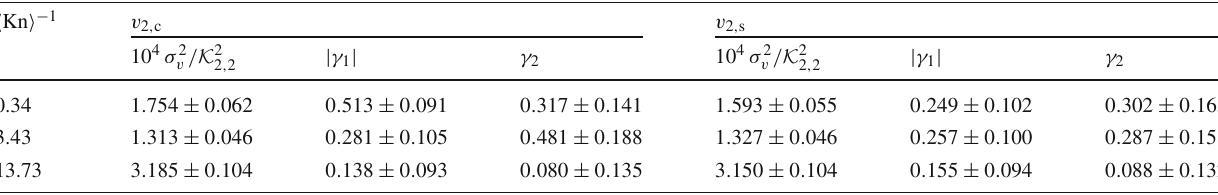
Table 2 Moments of the conditional probability distributions p v | ε (v 2 , c / s | ε 2 , c / s ) of the final-state flow harmonics computed for 10 4 events at b = 6 fm. The variance σ 2 v is divided by the square K 2